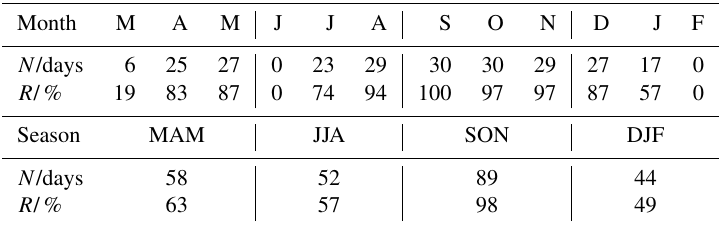
Table 2. Number of days when all instruments could provide data to the Cloudnet retrieval during every month and season. Months are indicated by their first letter, N is the number of days with data and R is the data coverage relative to the days in the respective month or season in percent.